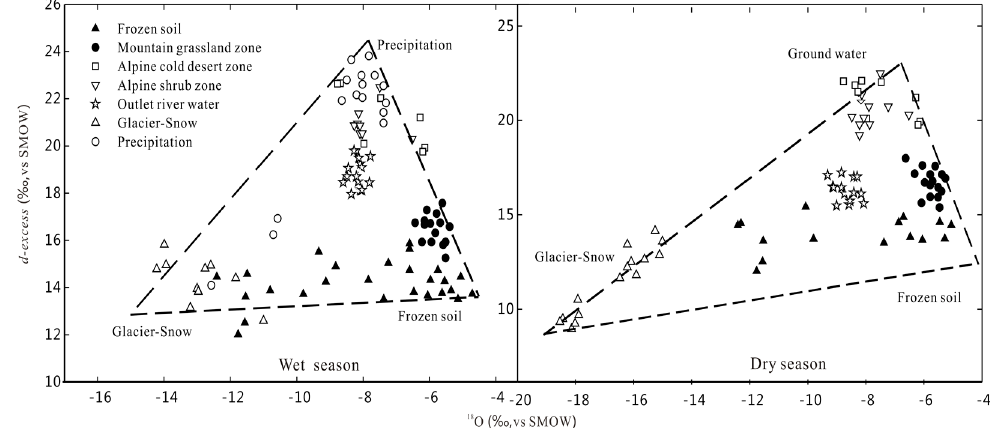
Figure 5 . Mixing diagram using 18 O and d in the wet and dry season.